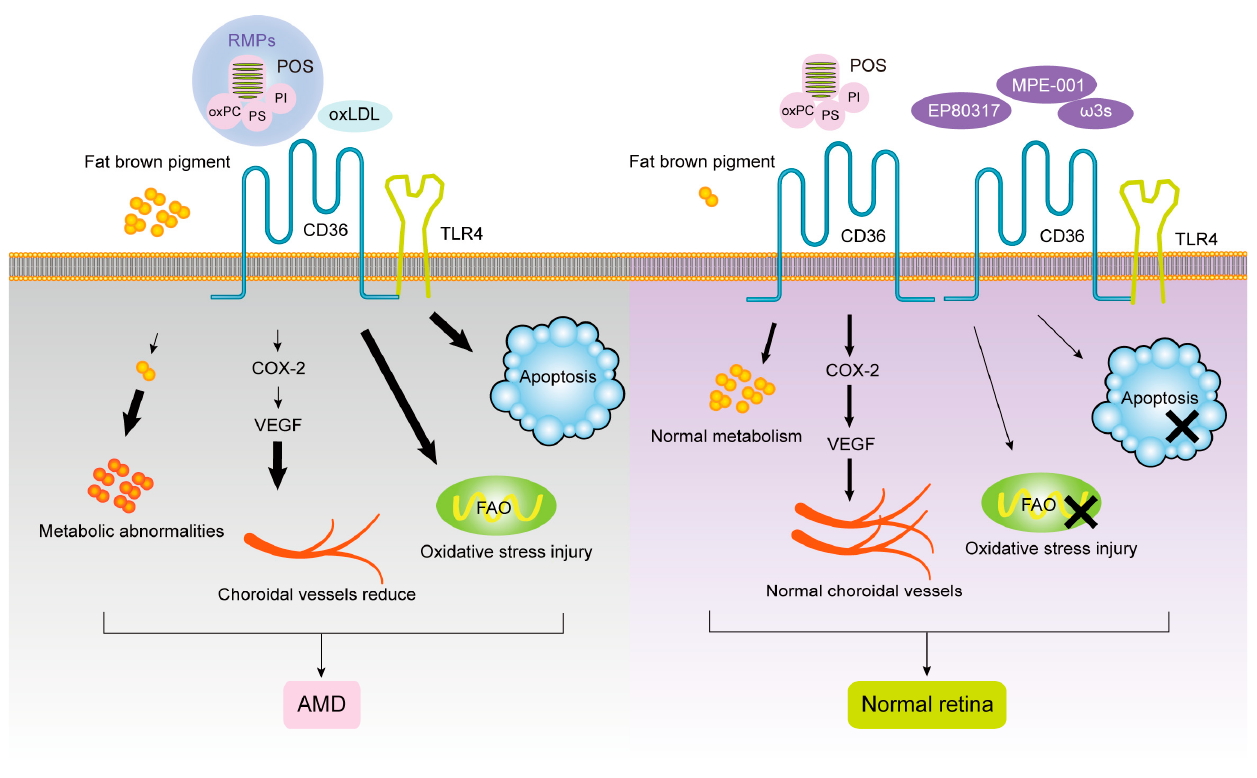
Figure 2. The roles of CD36 in AMD.